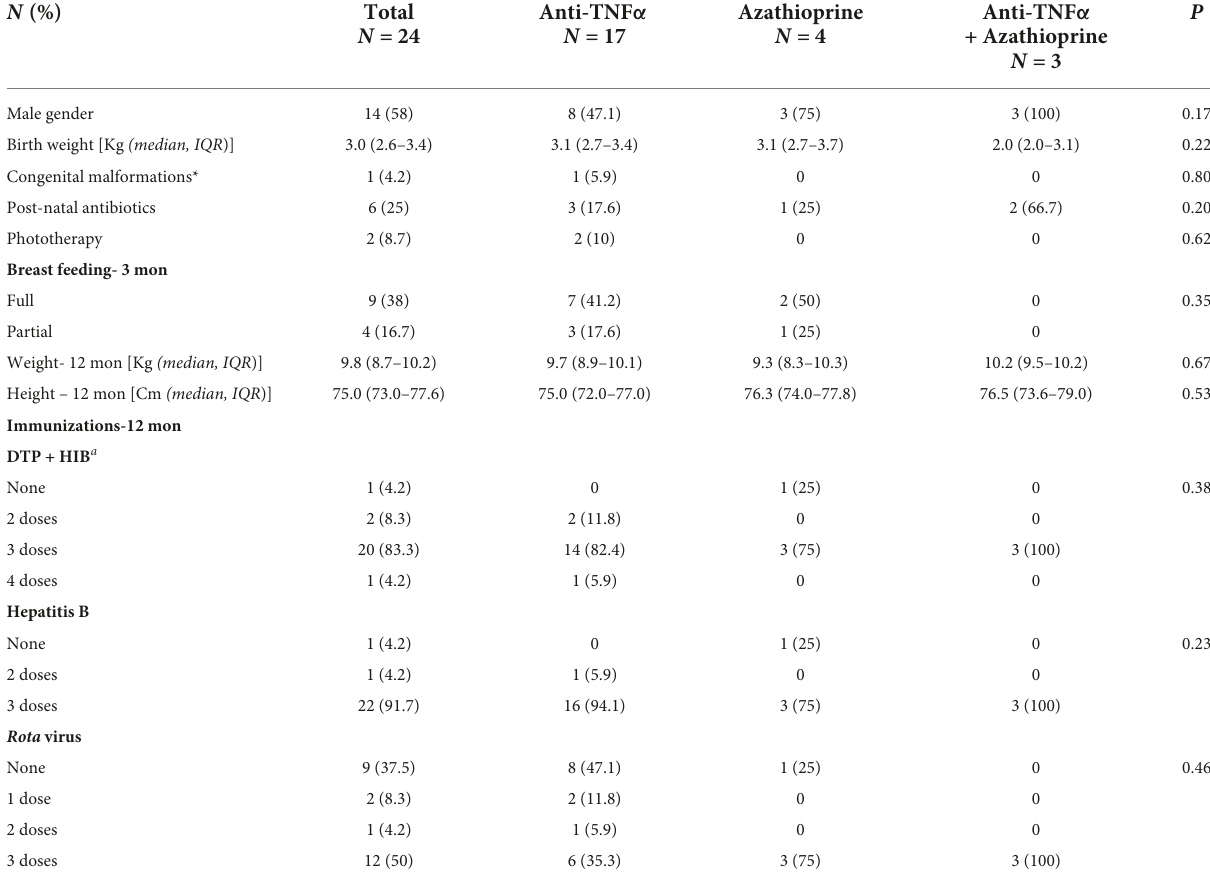
TABLE 2 Pregnancy outcome and 12-month follow-up of infants exposed in utero to anti-TNF α , azathioprine or combination therapy. N (%)